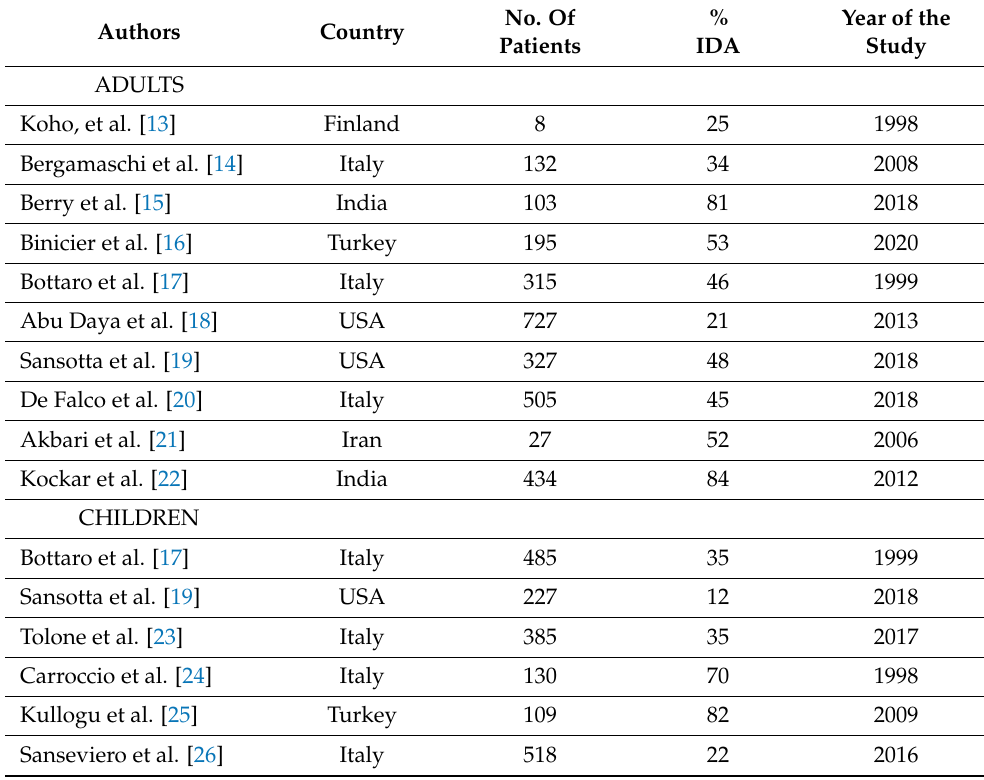
Table 1. Studies on prevalence of IDA in celiac